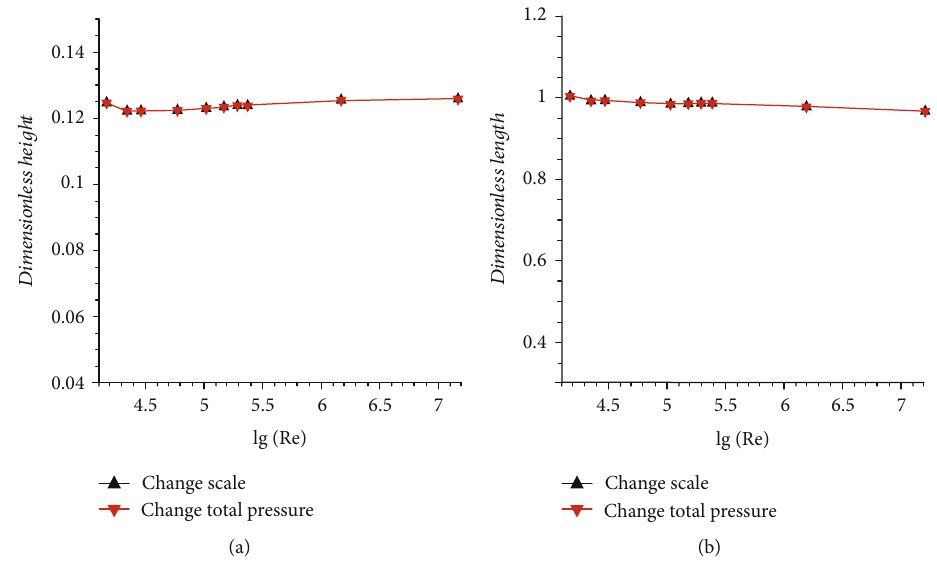
Figure 12: Comparison of the dimensionless separation bubble (a) heights and (b) lengths obtained by changing the scale and total pressure.